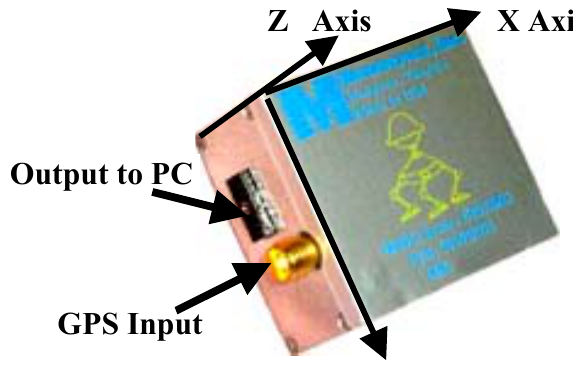
Figure 3 . The MIDG II GPS/INS device of Microbotics.